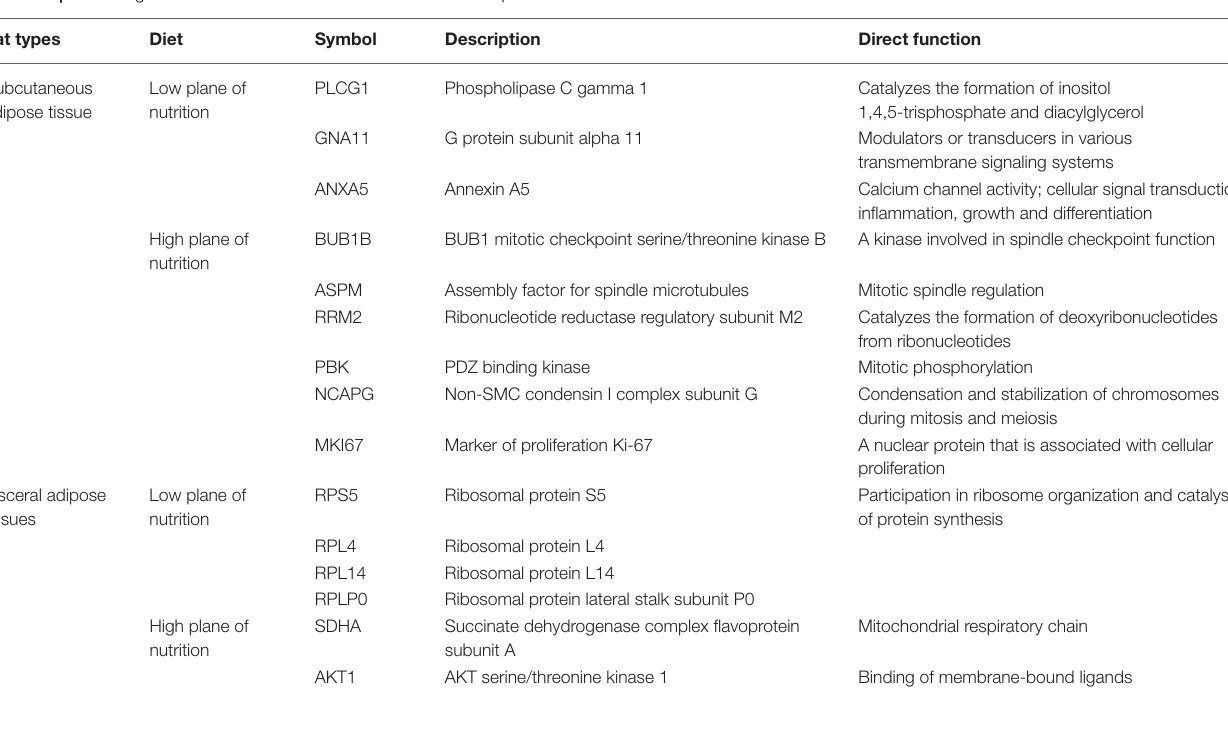
TABLE 1 | The hub genes identified in subcutaneous and visceral adipose